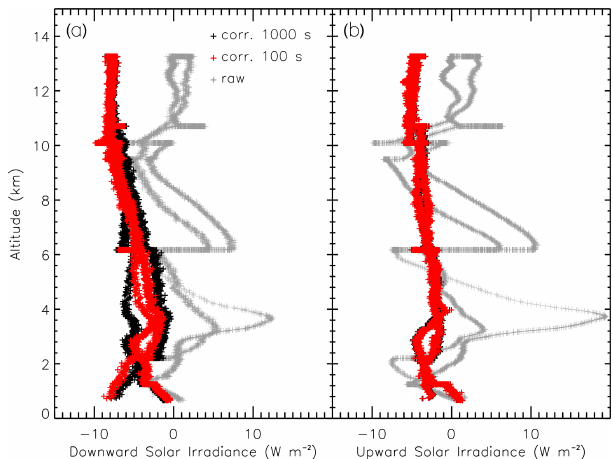
Figure 6. Profile of downward (a) and upward (b) solar irradiance during a night flight on 15 May 2019. Irradiances without (gray) and with dynamic thermal offset correction using the fast (100s high- pass filter, red) and slow (1000s high-pass filter, black) response fit are